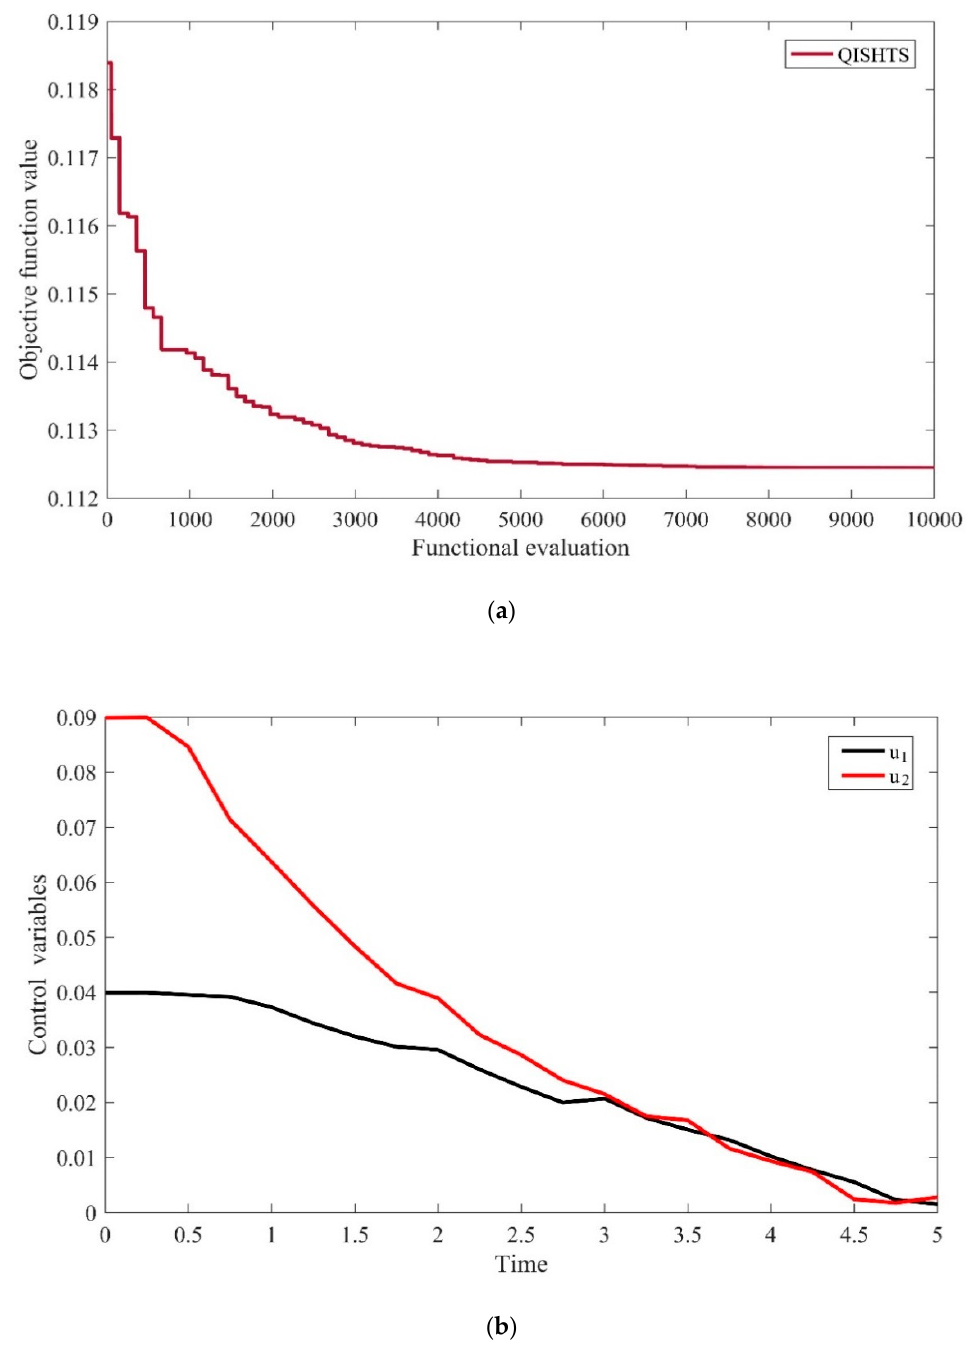
Figure 6. ( a ) Convergence graph of the QISHTS algorithm for the six-plate gas absorption tower model. ( b ) Optimal control trajectories for the six-plate gas absorption tower model. u 1 and u 2 portray the optimal control variables of this problem.